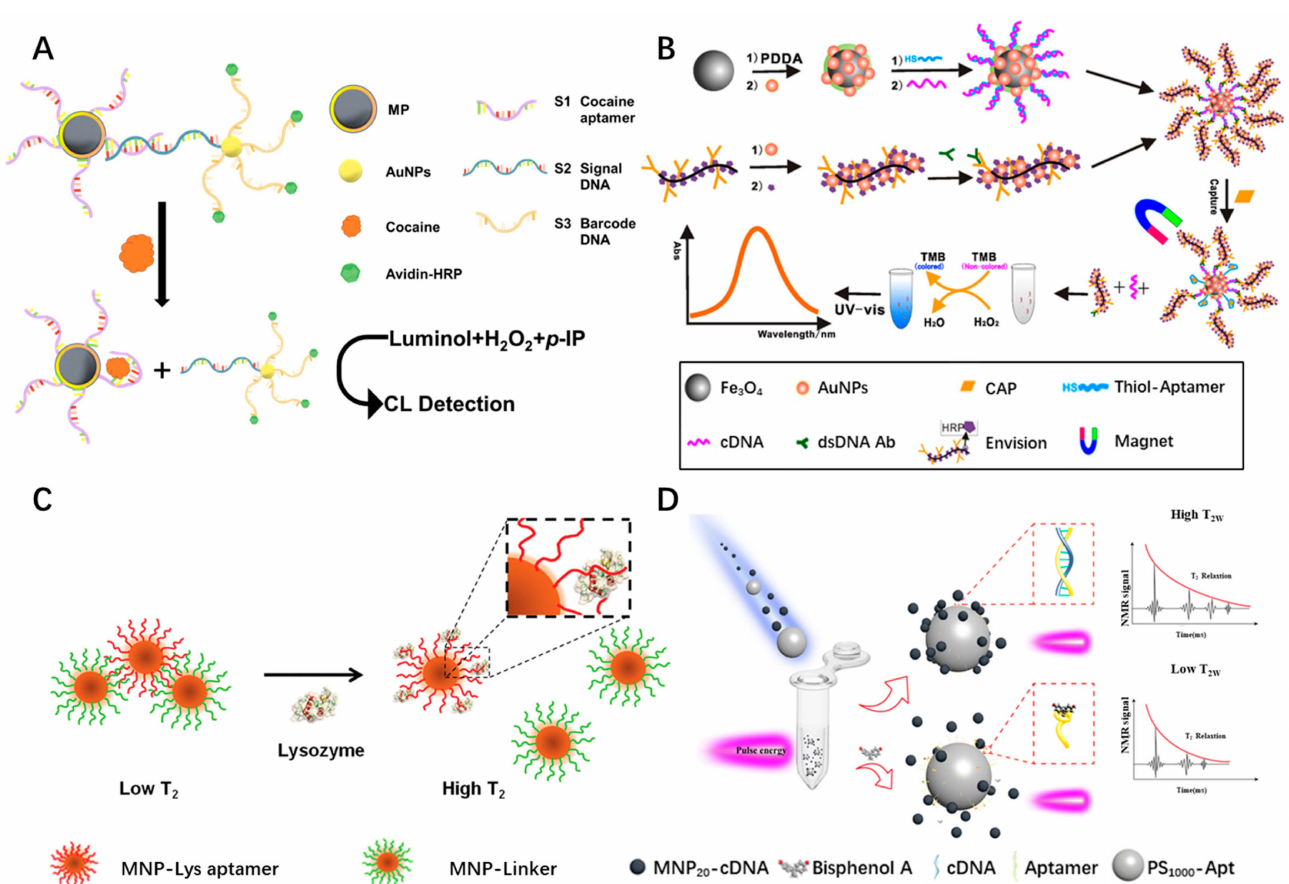
Figure 8. Competitive assay methods using chemiluminescence and magnetic relaxation switching (MRSw). ( A ) The chemiluminescence detection of cocaine using HRP-labeled aptamer and function- alized MPs. ( B ) The colorimetric aptasensor to detect CAP using ds-DNA Ab/EV-AuNPs-HRP as the signal tag, reproduced with permission from [85]. Copyright 2015 Sensors and Actuators B: Chemical. ( C ) The magnetic nanosensor for Lys detection based on MRSw, reprinted with permission from [87]. Copyright 2011 American Chemical Society. ( D ) PS-MRS sensor for the detection of BPA, reprinted with permission from [88]. Copyright 2021 American Chemical